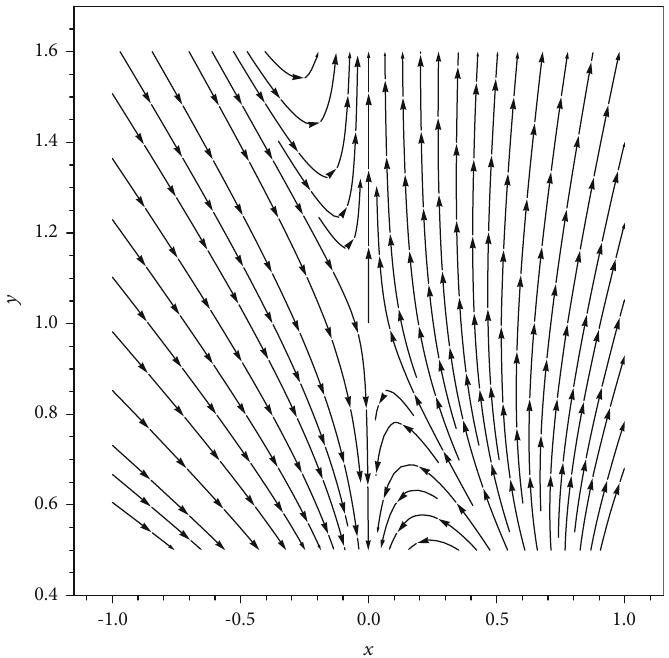
Figure 7: Shows the phase plot of the system without potential for γ = 4/3 showing unstable Q ð x = 0, y → 1 Þ when γ > 2/3 .